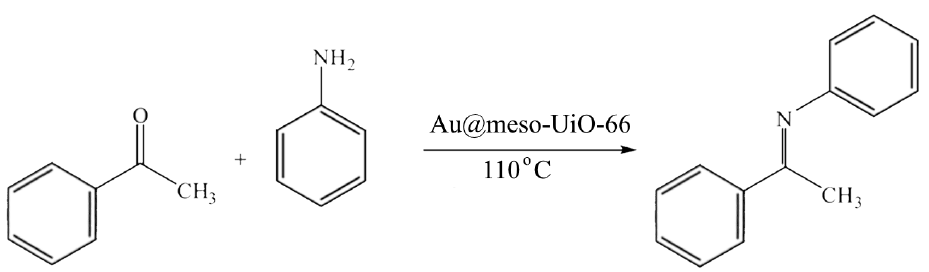
Scheme 2. The condensation reaction of acetophenone and aniline. Table 3. Catalytic performance and recyclability of the Au@meso-UiO-66 nanohybrid in the reaction of condensation of acetophenone and aniline.